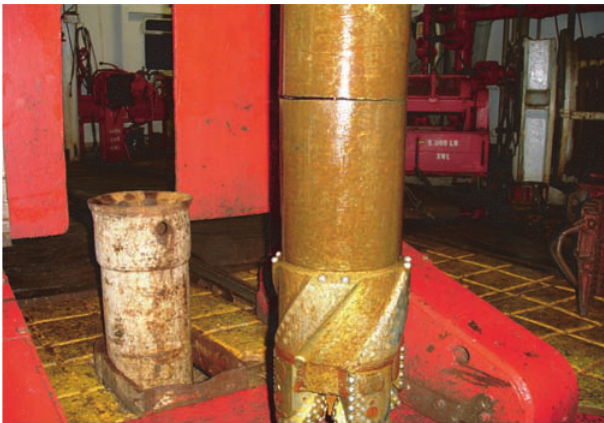
Figure 7. Torsional failure of the bit sub during Expedition 309. A horizontal gash opened for ~150° (11 inches) of the circumference of the 3⁄4-inch thick bit sub wall, ~15 inches from the bit, with more ragged fracture tips propagating a further ~75° around the pipe from each end of the clean fracture. When in tension with the drill bit hanging from the sub, the fracture opened up to 1 cm, and the bit was held on by only ~4.25 inches of the bit sub